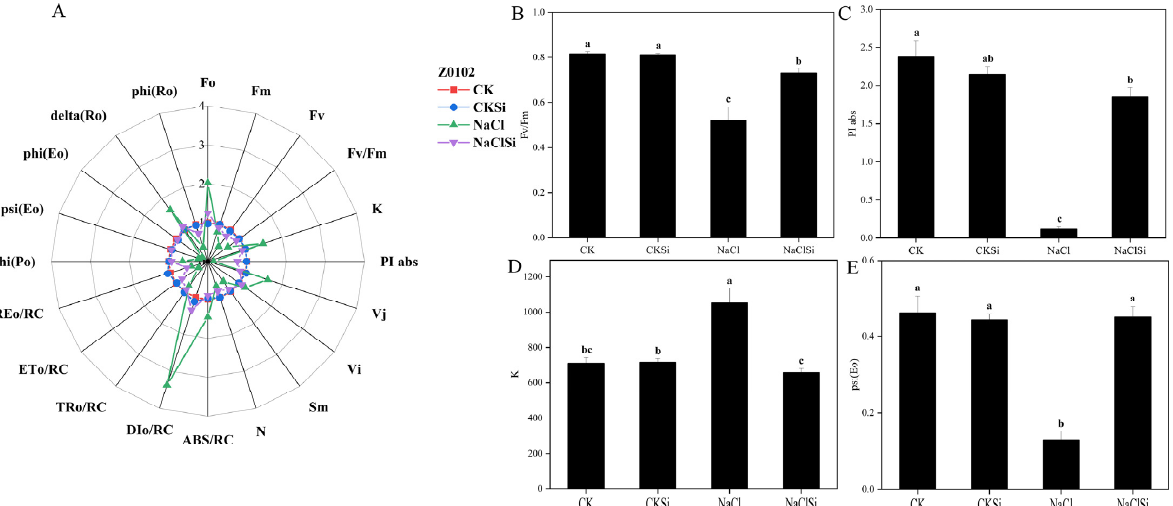
Figure 10. Analysis of selected JIP parameters derived from chlorophyll-a fluorescence in cotton genotype Z0102 under different treatments. ( A ) spider plot of fluorescence parameters of cotton leaves, and for each parameter, the value of control was set 1. ( B ) Fv/Fm. ( C ) fluorescence intensity of K point. ( D ) PIabs, performance index for energy conservation from photons absorbed by PSII until the reduction of intersystem electron acceptors. ( E ) Psi (Eo), the ratio of QA driven by exciton occupancy in excitons captured by the reaction center to reduce excitons to drive electron transfer to other electron acceptors in the electron transport chain beyond QA. Different letters mean significantly different among treatments at p ≤ 0.05.